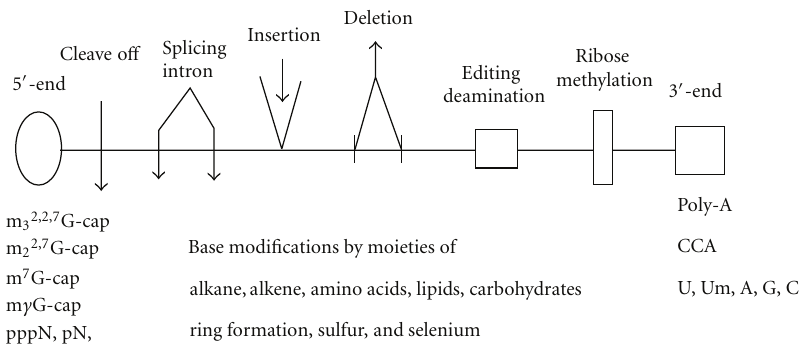
Figure 4: Summary of RNA modifications. Cotranscriptional and posttranscriptional RNA modifications are summarized.